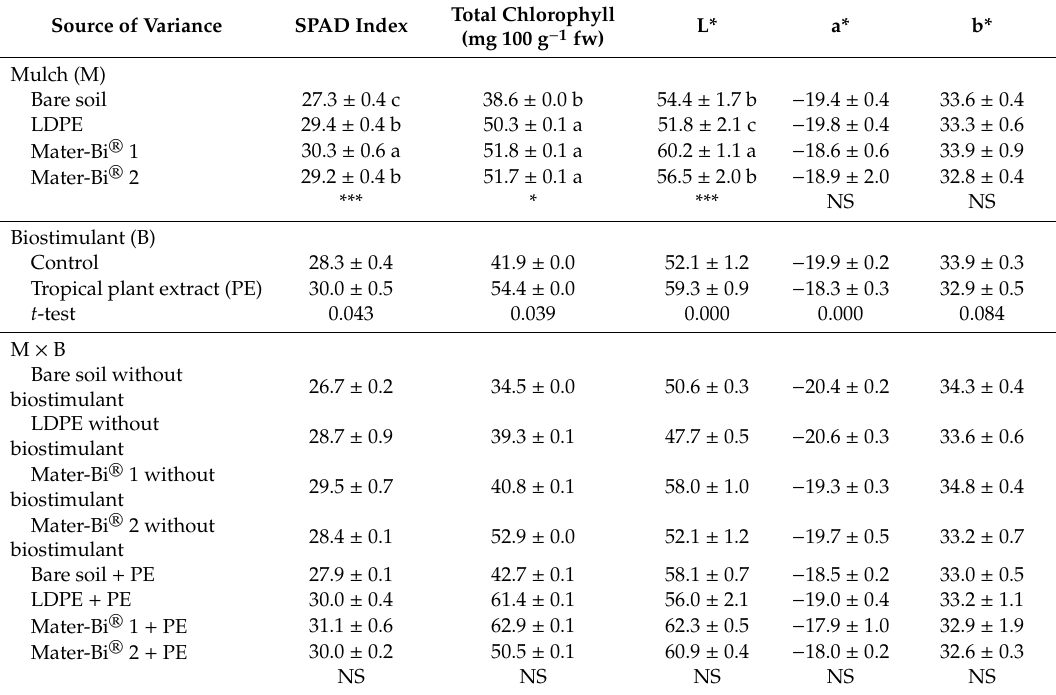
Table 2. Mean comparison and analysis of variance for Soil Plant Analysis Development (SPAD) index, total chlorophyll content, and Hunter color parameters L* (brightness), a* ( − a* = green) and b* ( + b* = yellow) of untreated and biostimulant-treated greenhouse lettuce grown under LDPE mulch and biodegradable (Mater-Bi ® 1 and Mater-Bi ® 2) mulching materials in relation to bare